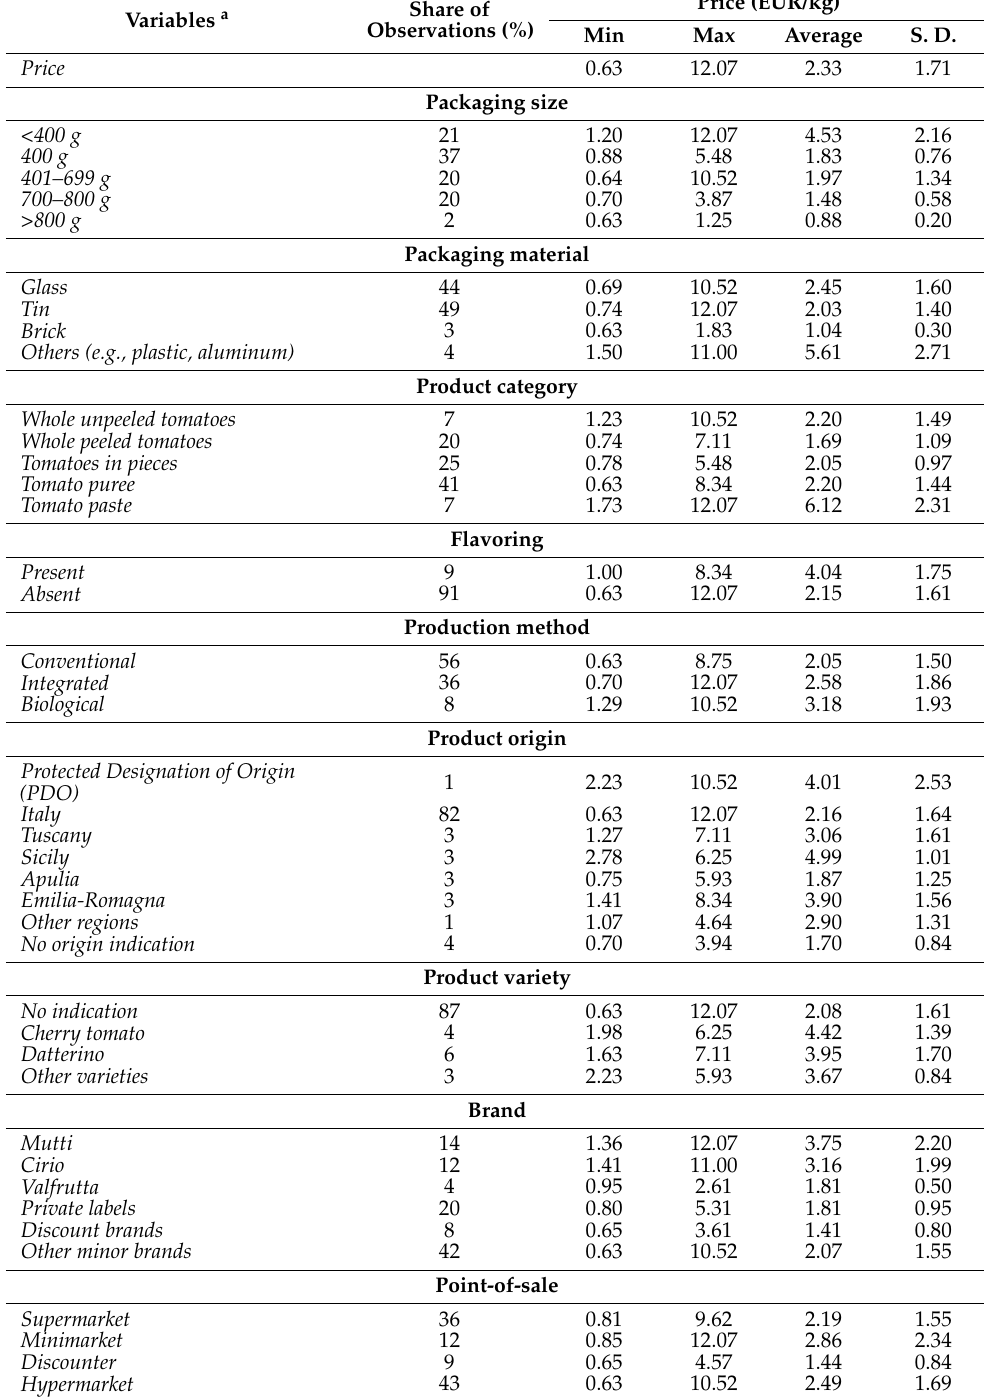
Table 2. List of variables and summary statistics (729